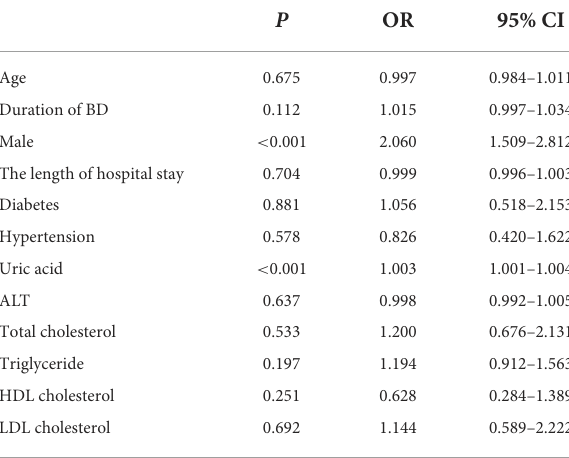
TABLE 3 Associated factors for overweight in patients with